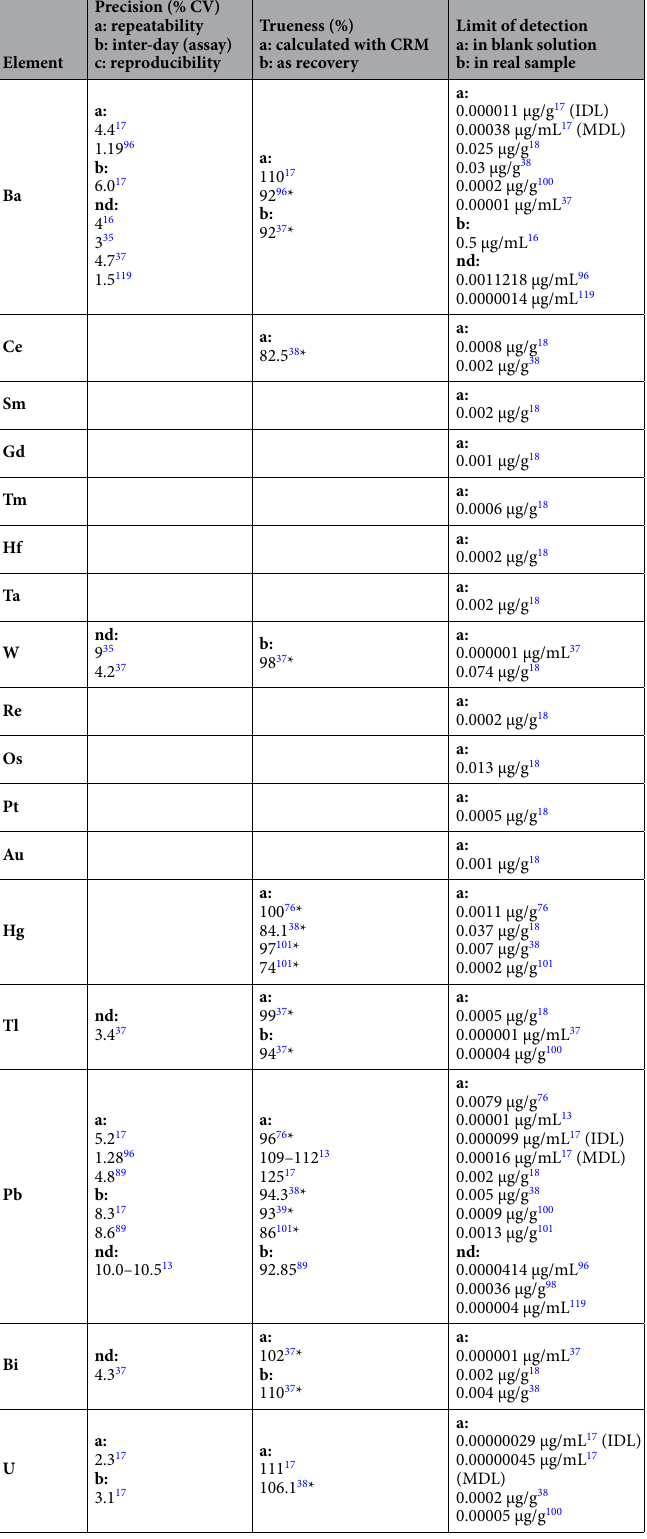
Table 4. Values of precision, trueness and detection limit for different elements determined by using ICP-MS. nd method of parameter determination was not defined; # Trueness expressed as a Bias; *Calculated based on the literature